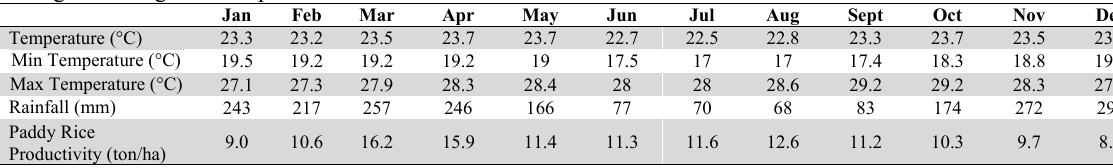
Paddy Rice Wind velocity Productivity (ton/ha)